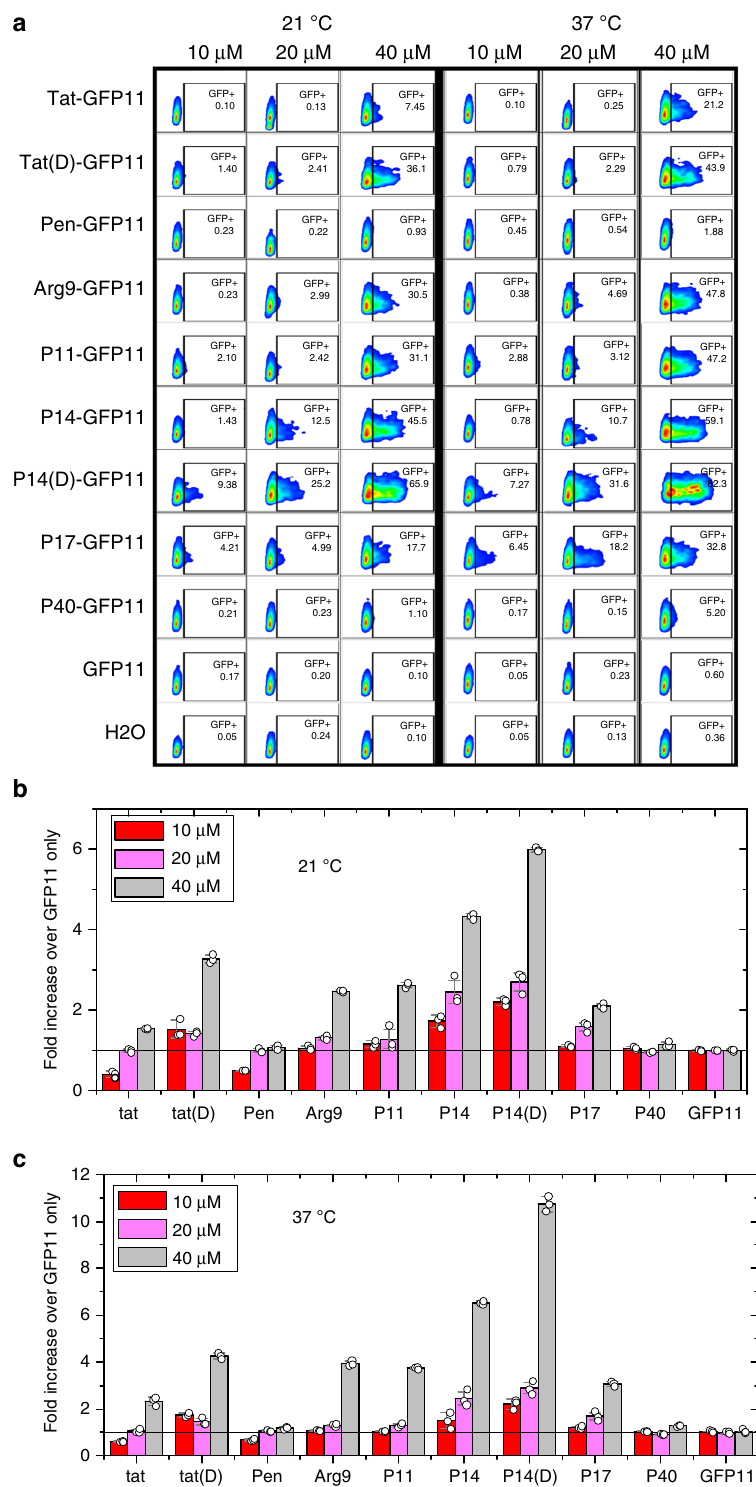
Fig. 4 PDEP-mediated delivery of an anionic peptide cargo. a Cells were transfected with a plasmid encoding for intact mCherry and non- fl uorescent GFP1 – 10. Cells were incubated, either at room temperature or at 37 °C, with varying concentrations of Peptide-GFP11 for 30 min and analyzed by fl ow cytometry. Live, single, mCherry-positive cells were fi rst gated. Within this population, mCherry and GFP intensities were measured for about 10,000 cells for each sample. The percentage of GFP-positive cells shown was determined by gating just above background GFP levels. b , c Average GFP intensity for cells treated at 21 °C ( b ) and at 37 °C ( c ) with CPP-GFP11 constructs. Averages are divided by the average intensity of cells treated with the GFP11 peptide alone. D-form versions of tat and P14 conjugated to an L-form GFP11 peptide were also analyzed. Error bars are standard deviations of the normalized data, which are shown as open circles, with three data points, from independent experiments, per